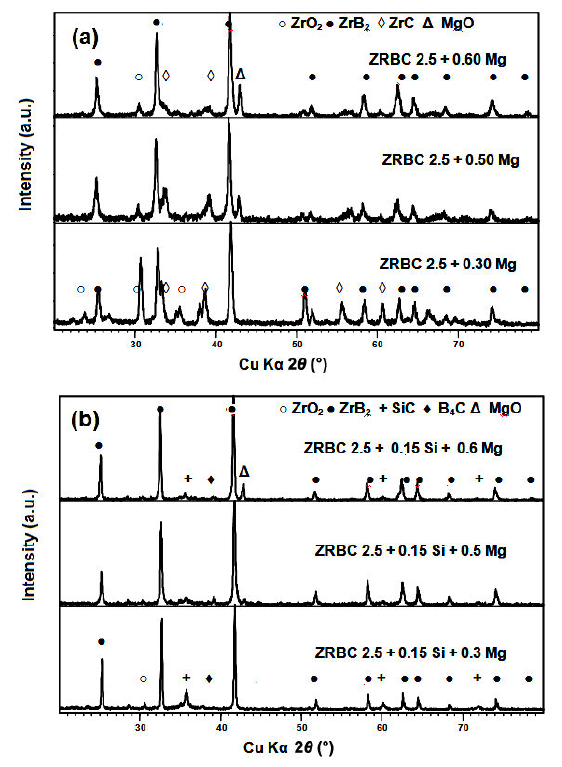
Fig. 7 Effect of Mg content on (a) ZRBC2.5 and (b) ZRBC2.5+Si. XRD patterns are after FT assisted reaction and leaching with HCl acid.